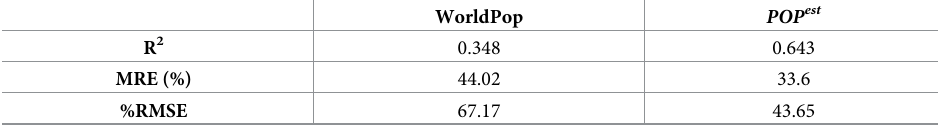
Table 2. Comparison of errors between POP est and Worldpop and real statistical data.